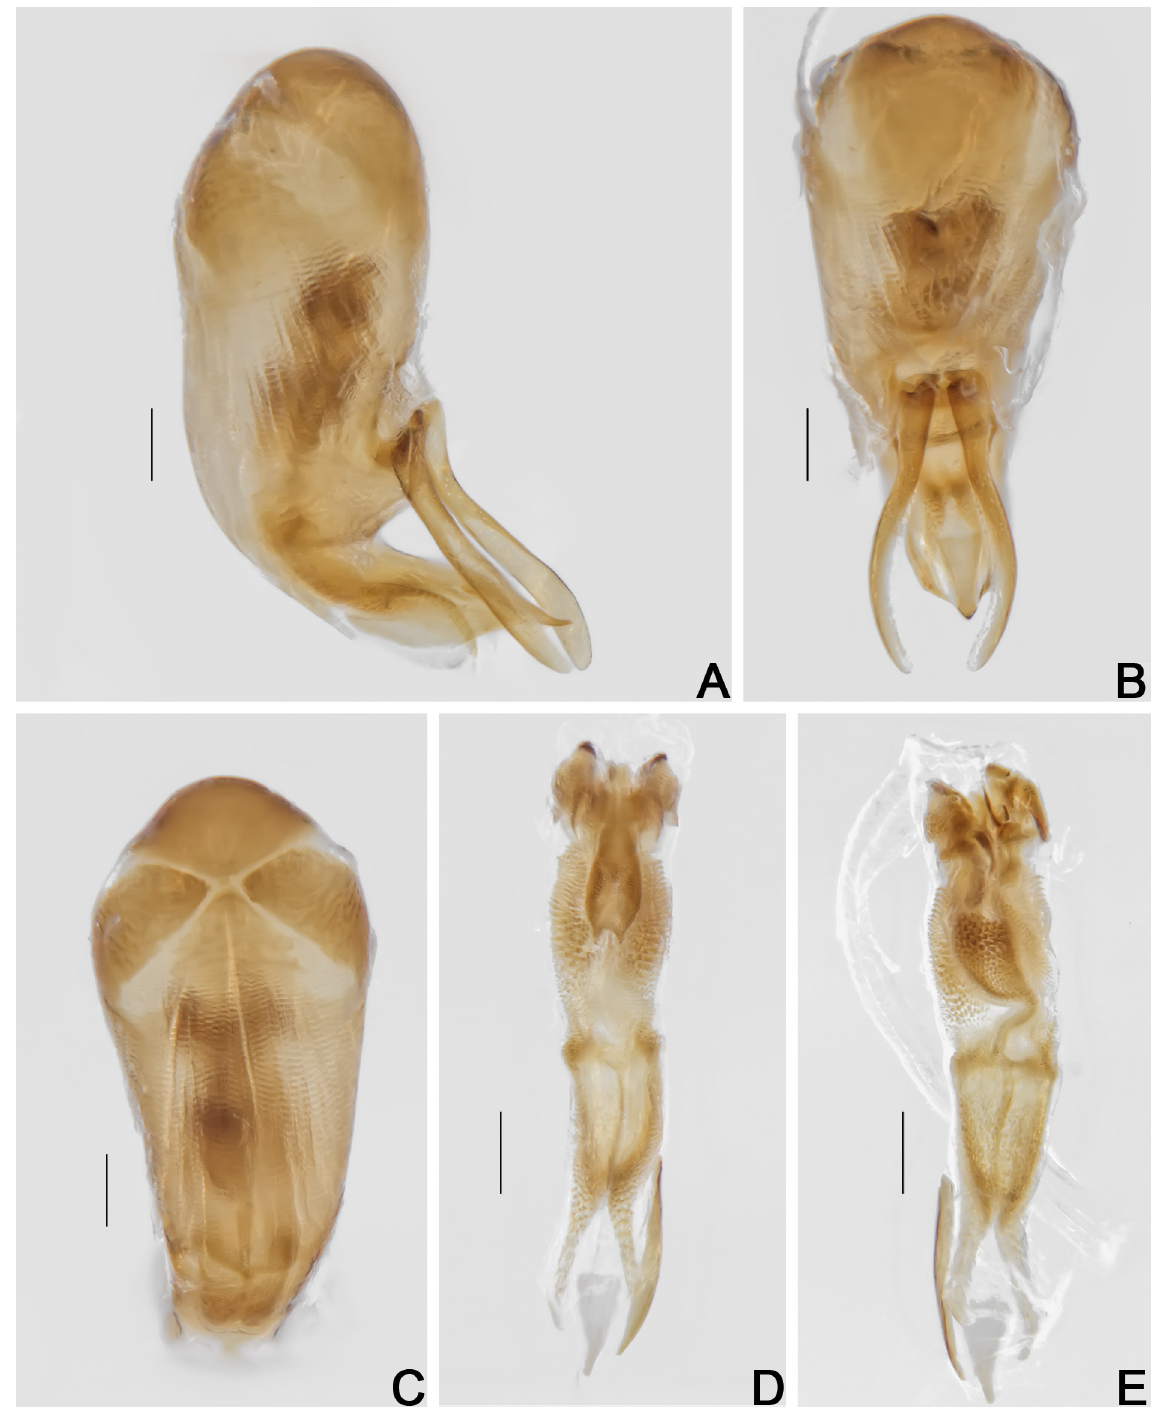
Fig. 36. Cyparium newtoni sp. nov., paratype, ♂ (CELC). A–C . Aedeagus. A . Lateral view. B . Frontal view. C . Dorsal view. D–E . Internal sac. D . Frontal view. E . Dorsal view. Specimen collected at Mata do Paraíso, Viçosa (MG, Brazil). Scale bars = 0.1